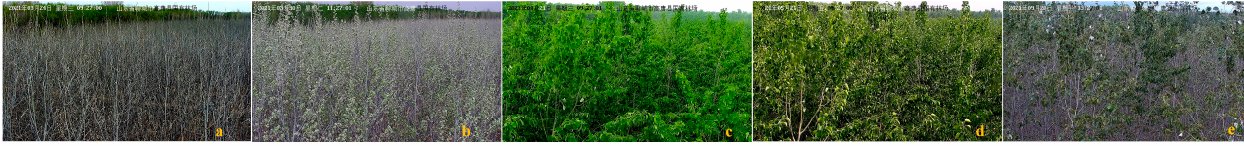
Figure 5. Variation of growing season in one year: (The experimental base was photographed in the state-owned forest farm of Gaotang County, Liaocheng City, Shandong Province, China).